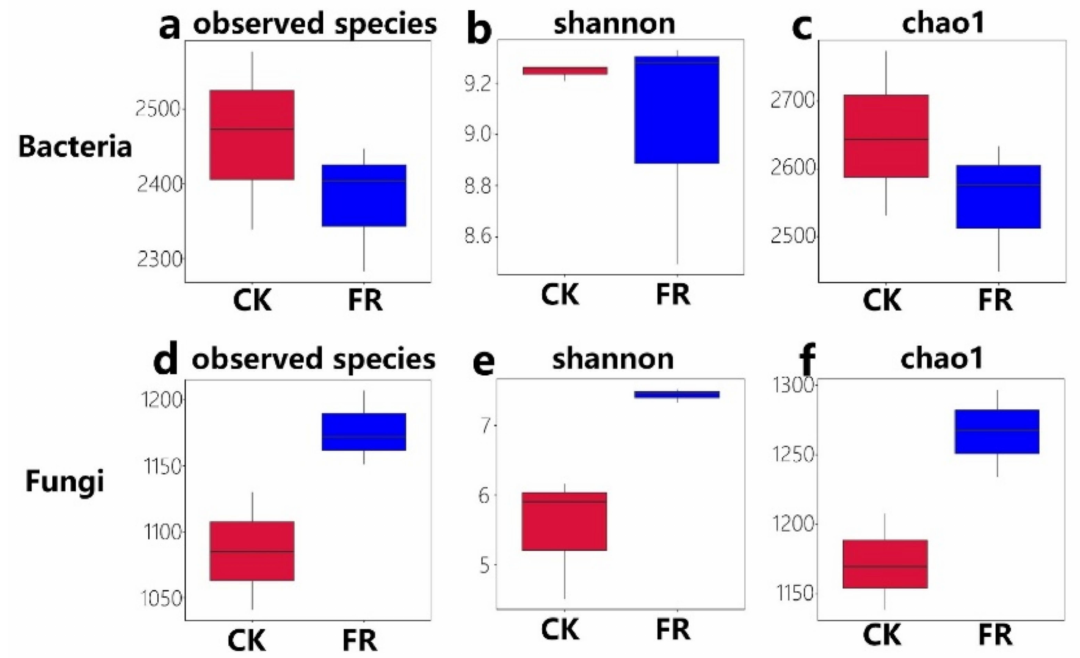
Figure 4. Alpha diversity of bacteria and fungi in the FR and CK zones of the fairy ring ecosystem. Boxes show: the top whisker represents the maximum value, the bottom whisker represents the minimum value, the line inside the box represents the median, the top margin of the box represents the upper quartile, and the lower margin of the box represents the lower quartile. ( a , d ) observed species indices of bacteria and fungi; ( b , e ) shannon indices of bacteria and fungi; ( c , f ) chao1 indices of bacteria and